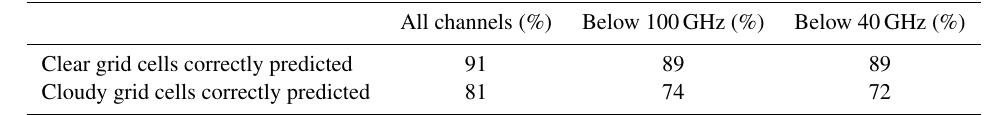
Table 3. Results of a binary classification over the ocean for different MW frequency ranges.